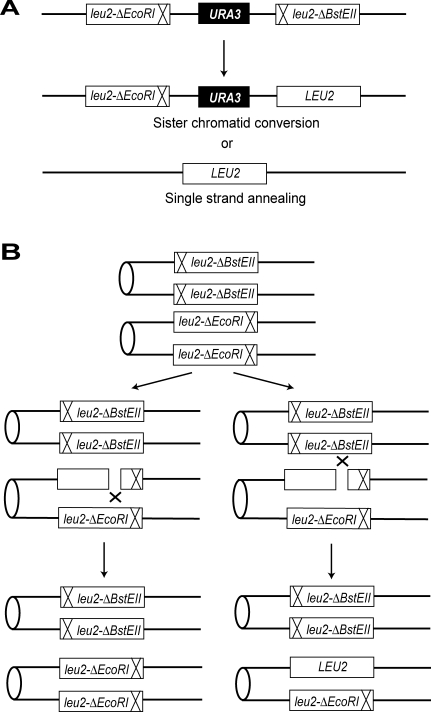
Recombination Assays Used in This Study(A) The direct repeat recombination assay measures intra-chromosomal and sister chromatid recombination events that generate a functional LEU2 allele from two leu2 heteroalleles. The URA3 marker between the heteroalleles permits discrimination between sister chromatid conversion events (Leu+ Ura+ recombinants) and SSA (Leu+ Ura− recombinants).(B) The interhomolog recombination assay measures recombination between leu2 heteroalleles on homologous chromosomes in diploid cells. Chromosomes are shown following DNA synthesis and reflect a pair of sister chromatids for each chromosome homolog. A recombinogenic lesion occurring at the LEU2 locus is most often repaired using the template on the sister chromatid, which is a conservative event resulting in no loss or gain of genetic information (left). However, a gene conversion event or reciprocal exchange between two homologous chromosomes can generate a functional LEU2 allele (right).